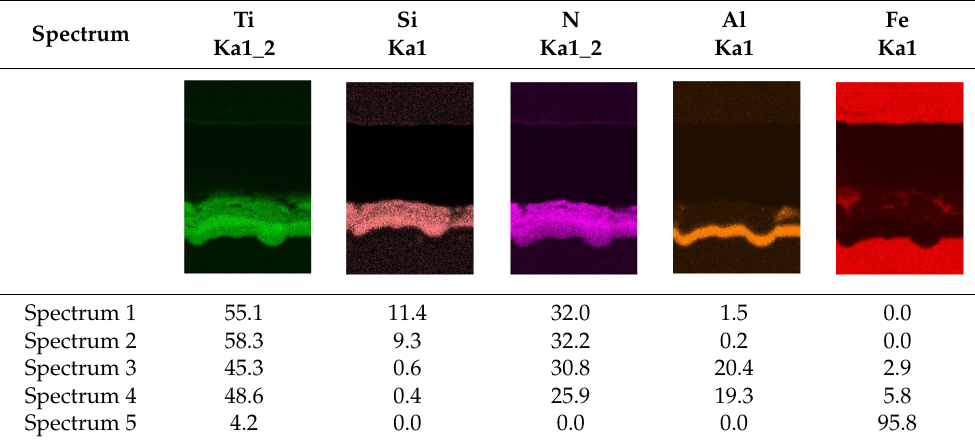
Table 3. Chemical composition of the TiSiN coating by element.